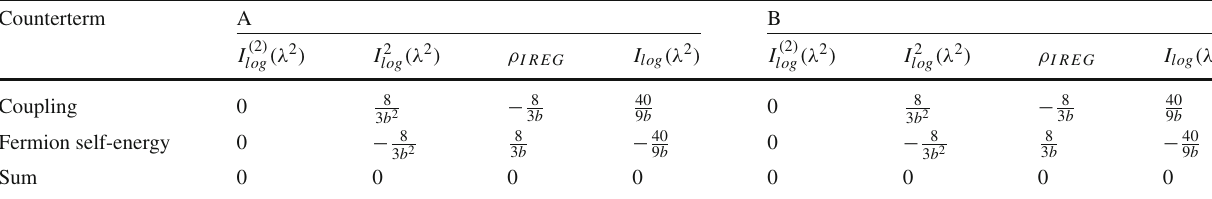
Table 8 Counterterm results for spinorial QED using IREG where ρ IREG = I log (λ 2 ) ln